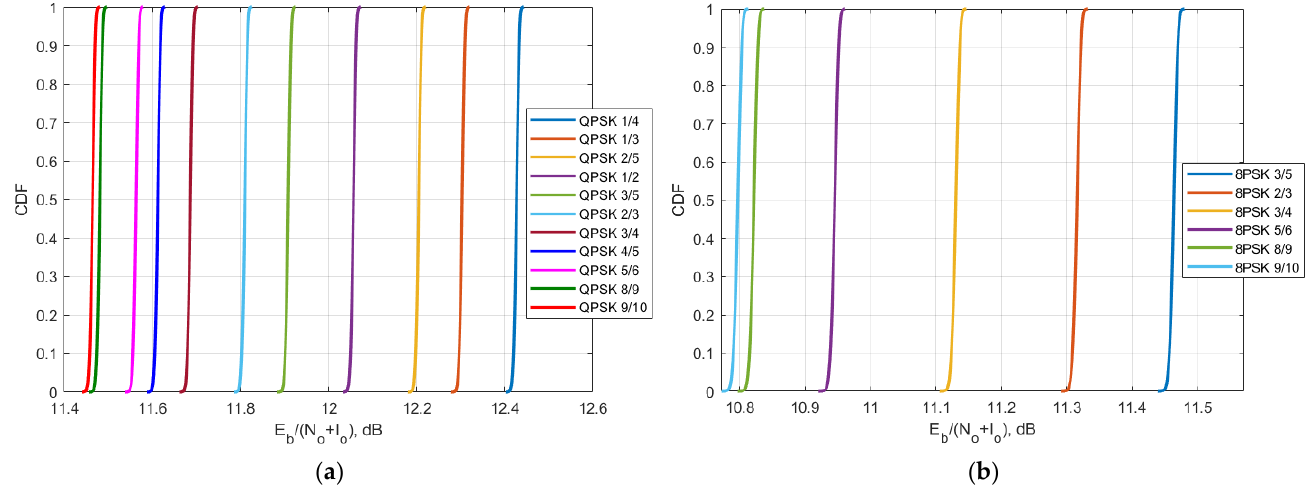
Figure 15. The CDF of E b /N o +I o of Yamal 183E: ( a ) for QPSK modulation; ( b ) 8PSK modulation.